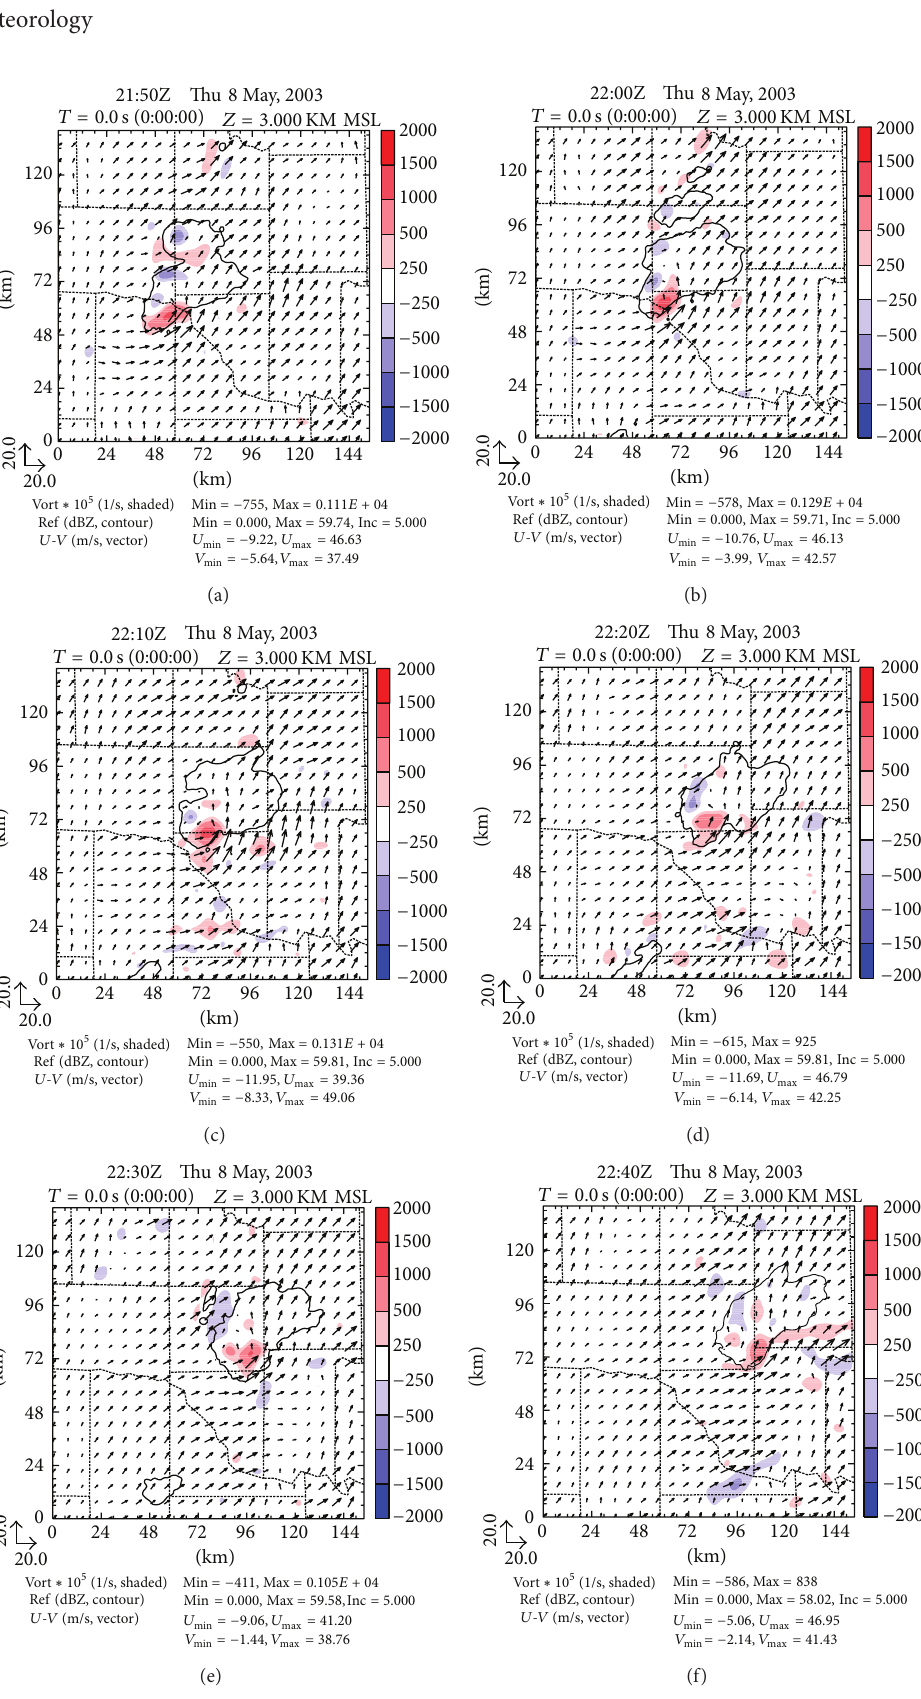
Figure 8: 3km vertical vorticity (10 −5 s −1 ) and horizontal wind vectors with the 35 dBZ reflectivity contour outlined from the control